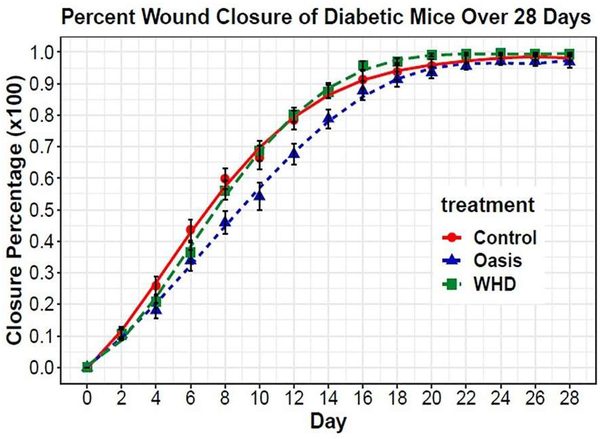
Polynomial regression analysis among treatment groups over 28 days. Percent wound closure was standardized to day 0 for each succeeding measurement. Shown values are means ± SEM.